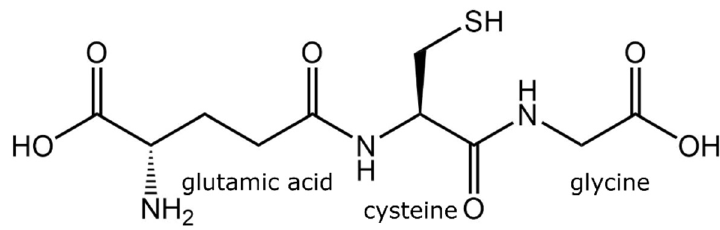
Figure 3. Chemical structure of tripeptides in glutathione.